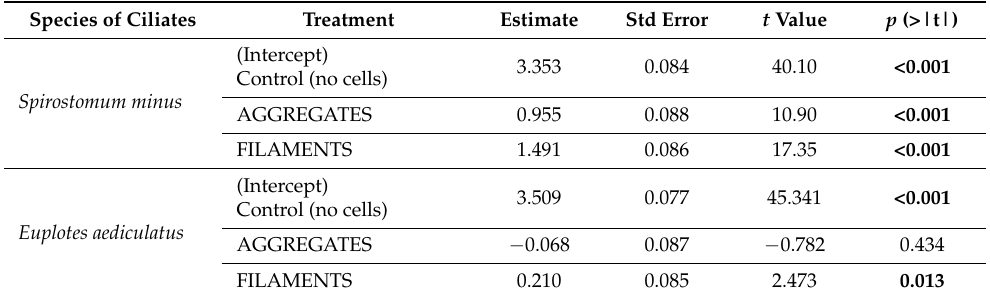
Table 3. The effect of A. flos-aquae filaments morphology (single filaments or aggregates) on ciliate species, p —statistical significances are